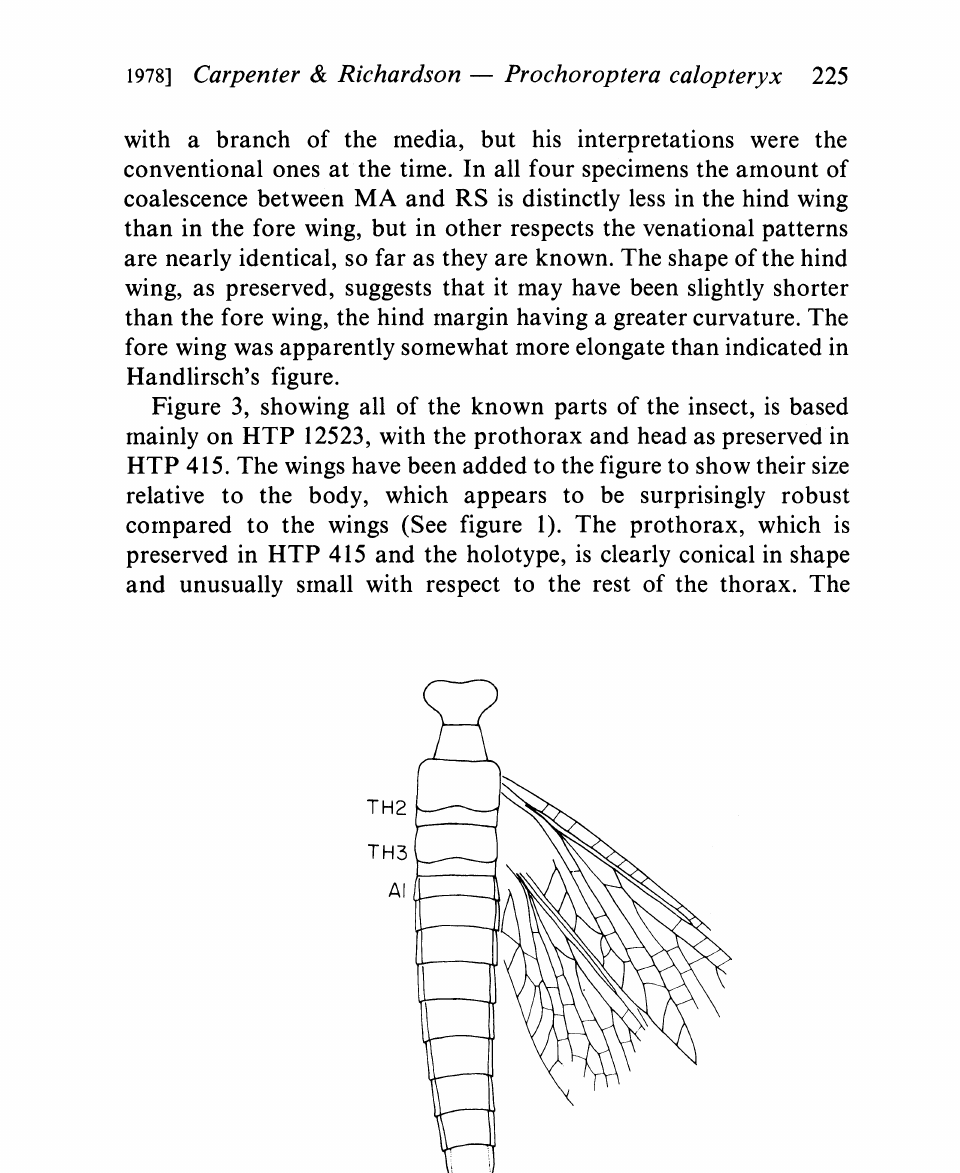
Figure 3. Prochoroptera calopteryx. Drawing of wings and body, as known; based mainly on specimen HTP 12523 (reverse) with prothorax and head added from specimen HTP 415. TH2, mesothorax; TH3 metathorax; AI, first abdominal